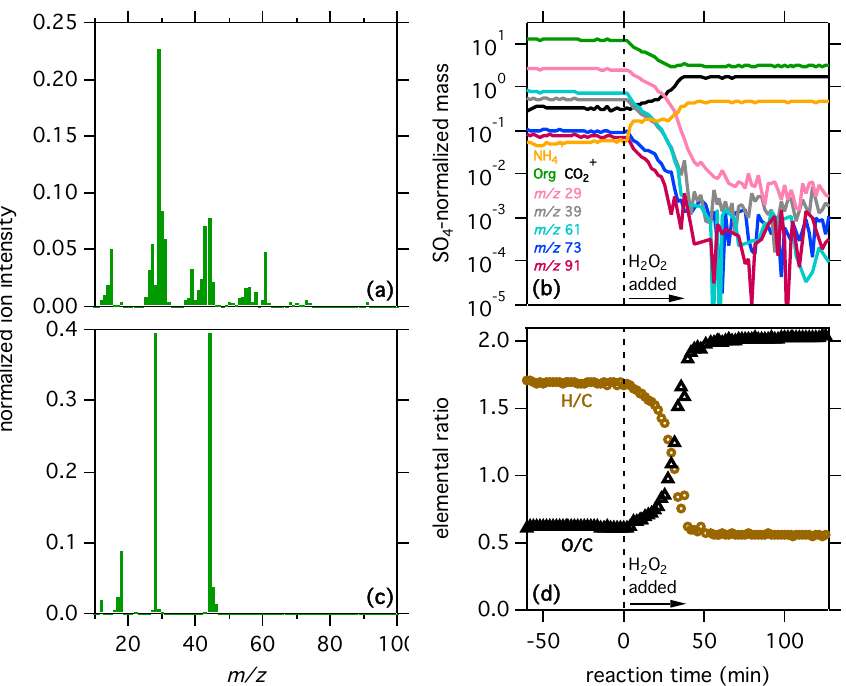
Figure 4. Same as Fig. 3, but for the oxidation of erythritol within submicron particles (chamber experiments): (a) AMS spectra of un- reacted erythritol; (b) sulfate-normalized mass concentrations of total organic (Org), ammonium (NH + erythritol ( m/z 29, 39, 61, 73, 91) as a function of reaction time; (c) AMS spectra of oxidation products; and (d) oxygen-to-carbon and hydrogen-to-carbon ratios as a function of reaction